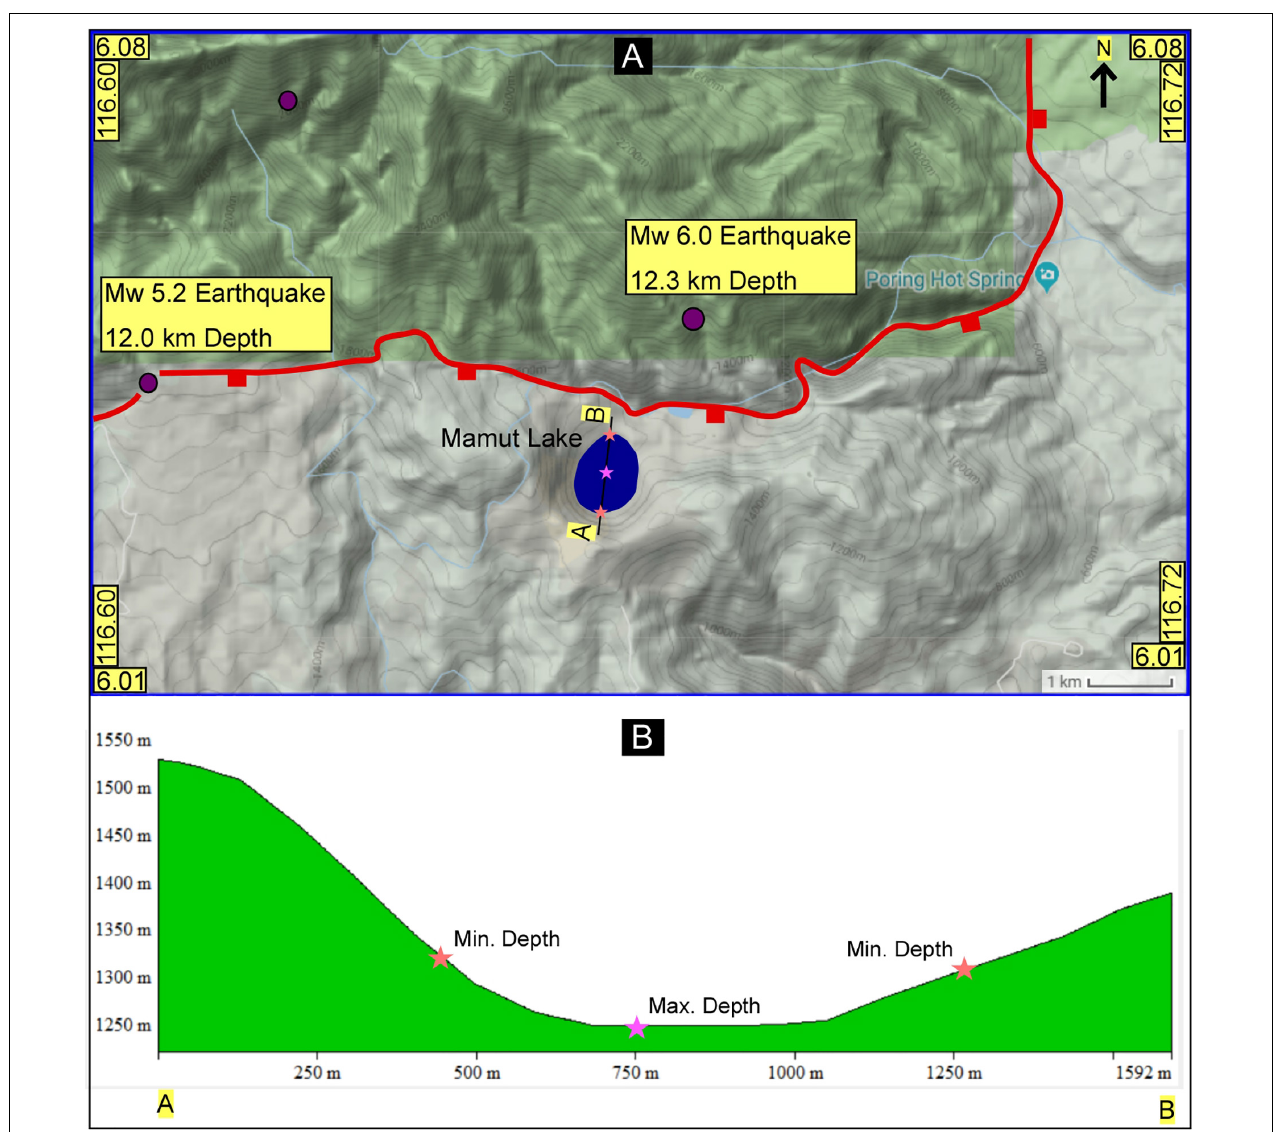
FIGURE 9 | Location and topographic map of the Mamut Lake in Ranau, which is an abandoned mine pit, and poses environmental and flood hazards. The topographic profile across the mine pit is shown in panels (A,B)